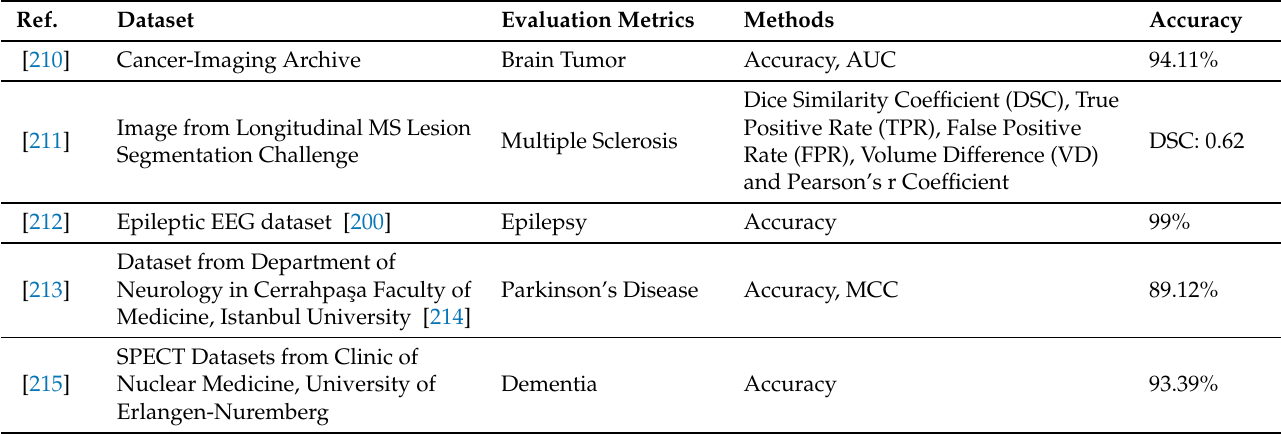
Table 9. GMM classifier result analysis on various NDs